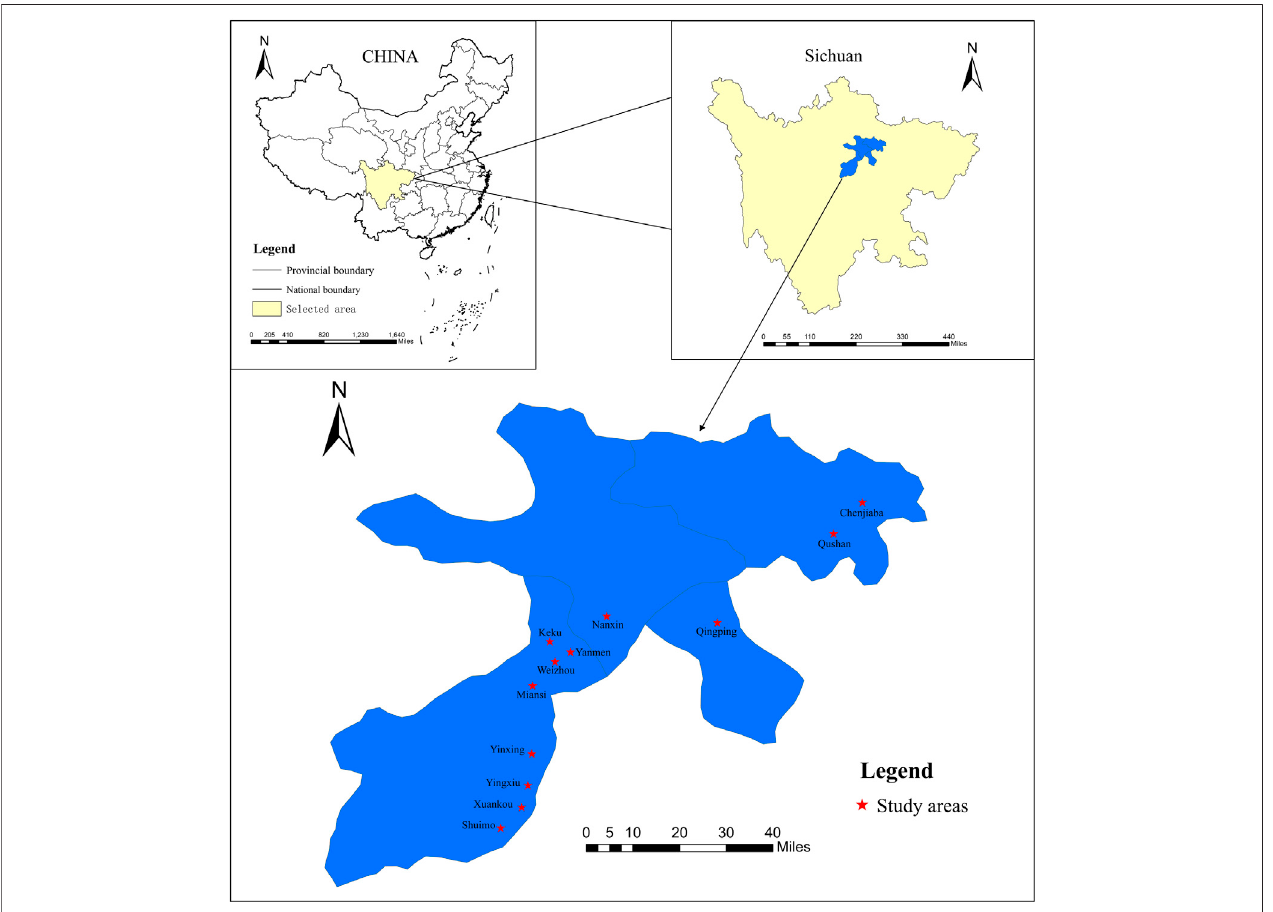
FIGURE 1 | The location of sample towns and